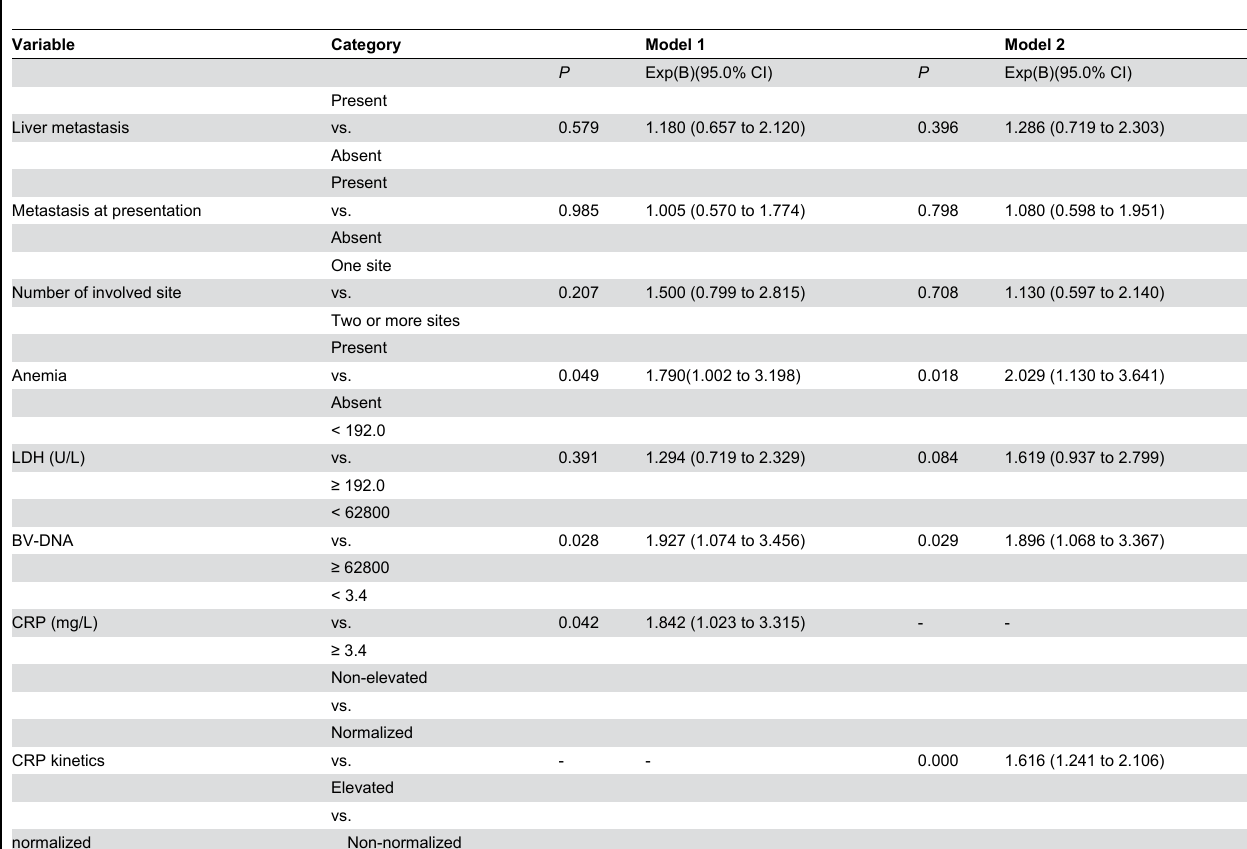
Table 3. Multivariate analysis of prognostic factors for patients with metastatic nasopharyngeal carcinoma.